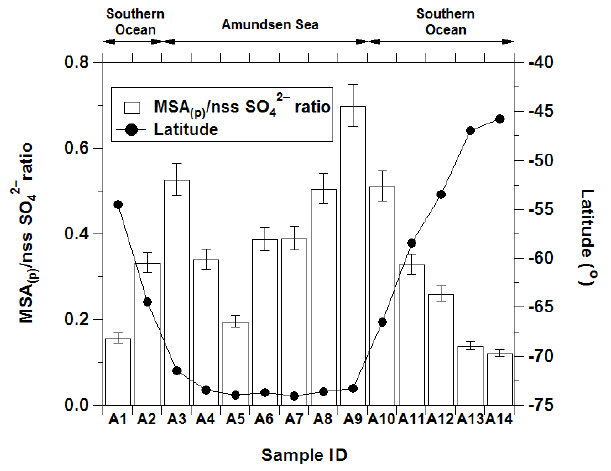
Figure 5. MSA ( p ) / nss SO 2 − ratio against aerosol sample ID. Dou- 4 ble arrows show the sampling locations of aerosol samples. The black solid line with circles indicates the latitude of the halfway point between each aerosol sampling start point and endpoint.